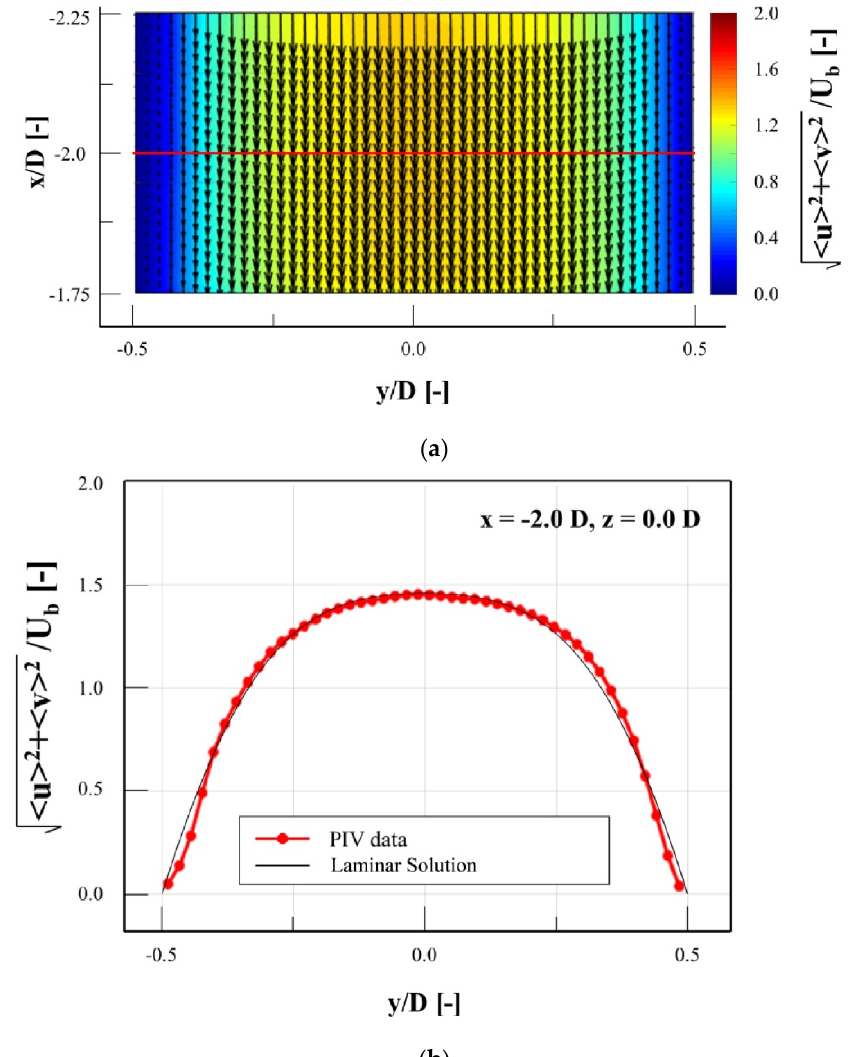
Figure 6. Inlet flow conditions: ( a ) velocity contour superimposed with velocity vectors upstream of the metal foam replica; ( b ) the comparison of velocity profiles from PIV measurements (experimental) and laminar solution.